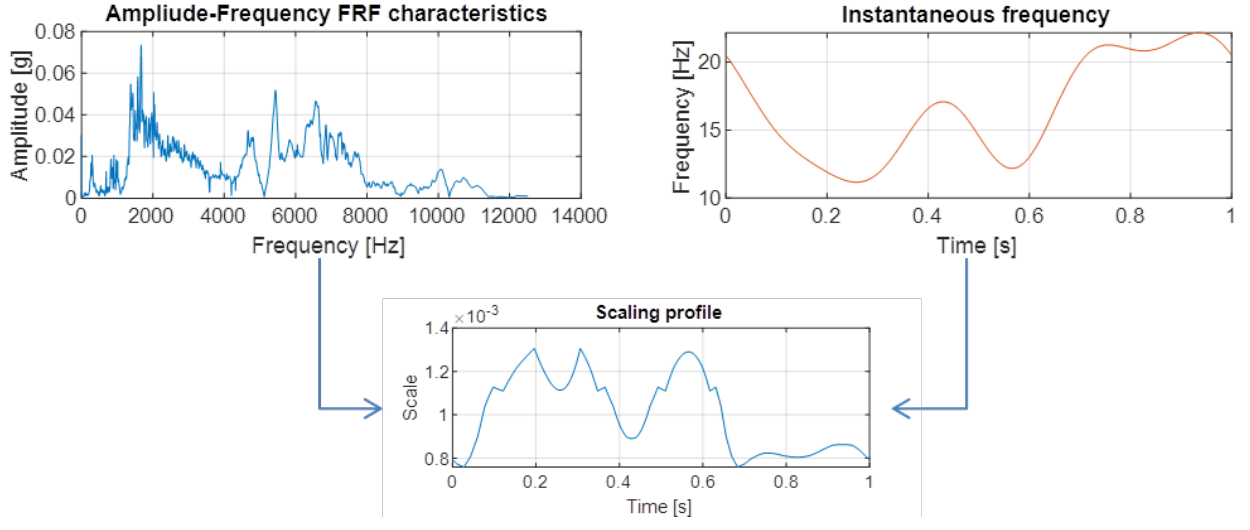
Figure 12. Calculation of amplitude of pulses.